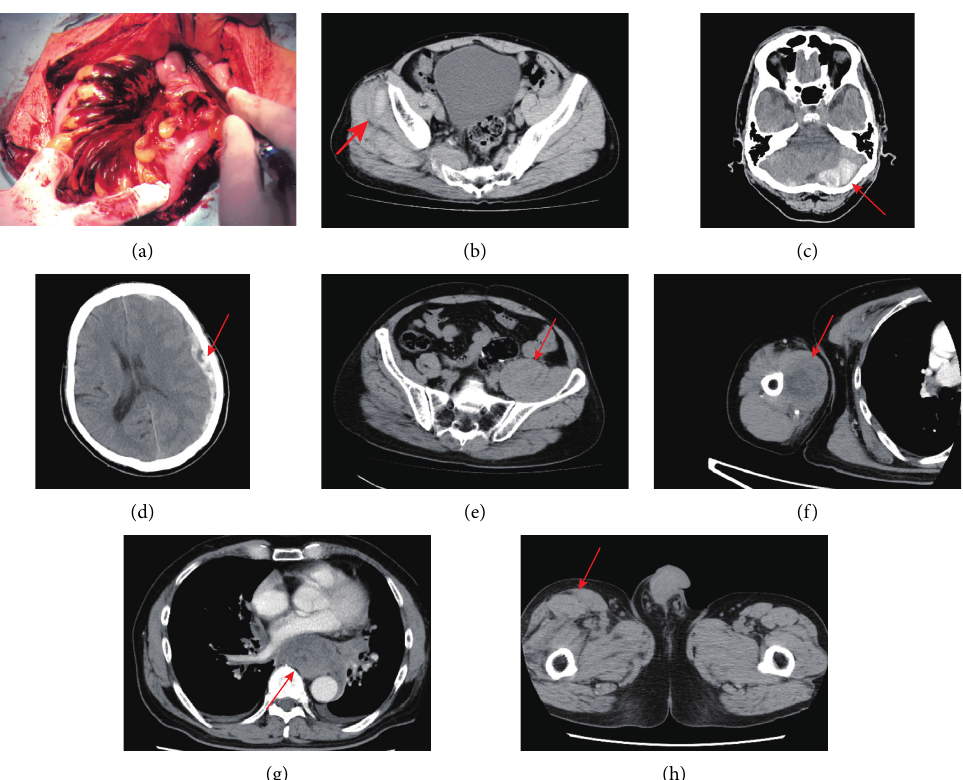
Figure 1: Major bleeding events that occurred during the course of the disease. 55 years old: intestinal hematoma (a). 59 years old: right glenohumeral and small pelvic cavity hematoma (b). 60 years old: left subacute subdural hematoma and small pelvic cavity hematoma (c). 60 years old: left acute subdural hematoma (d). 63 years old: intramuscular hematoma in the left iliopsoas muscle (e). 67 years old: right brachial intramuscular hematoma (f). 69 years old: intramediastinal hemorrhage (g). 70 years old: right intramuscular hematoma in the right thigh (h). (b)–(h) were light and managed with conservative treatment with tranexamic